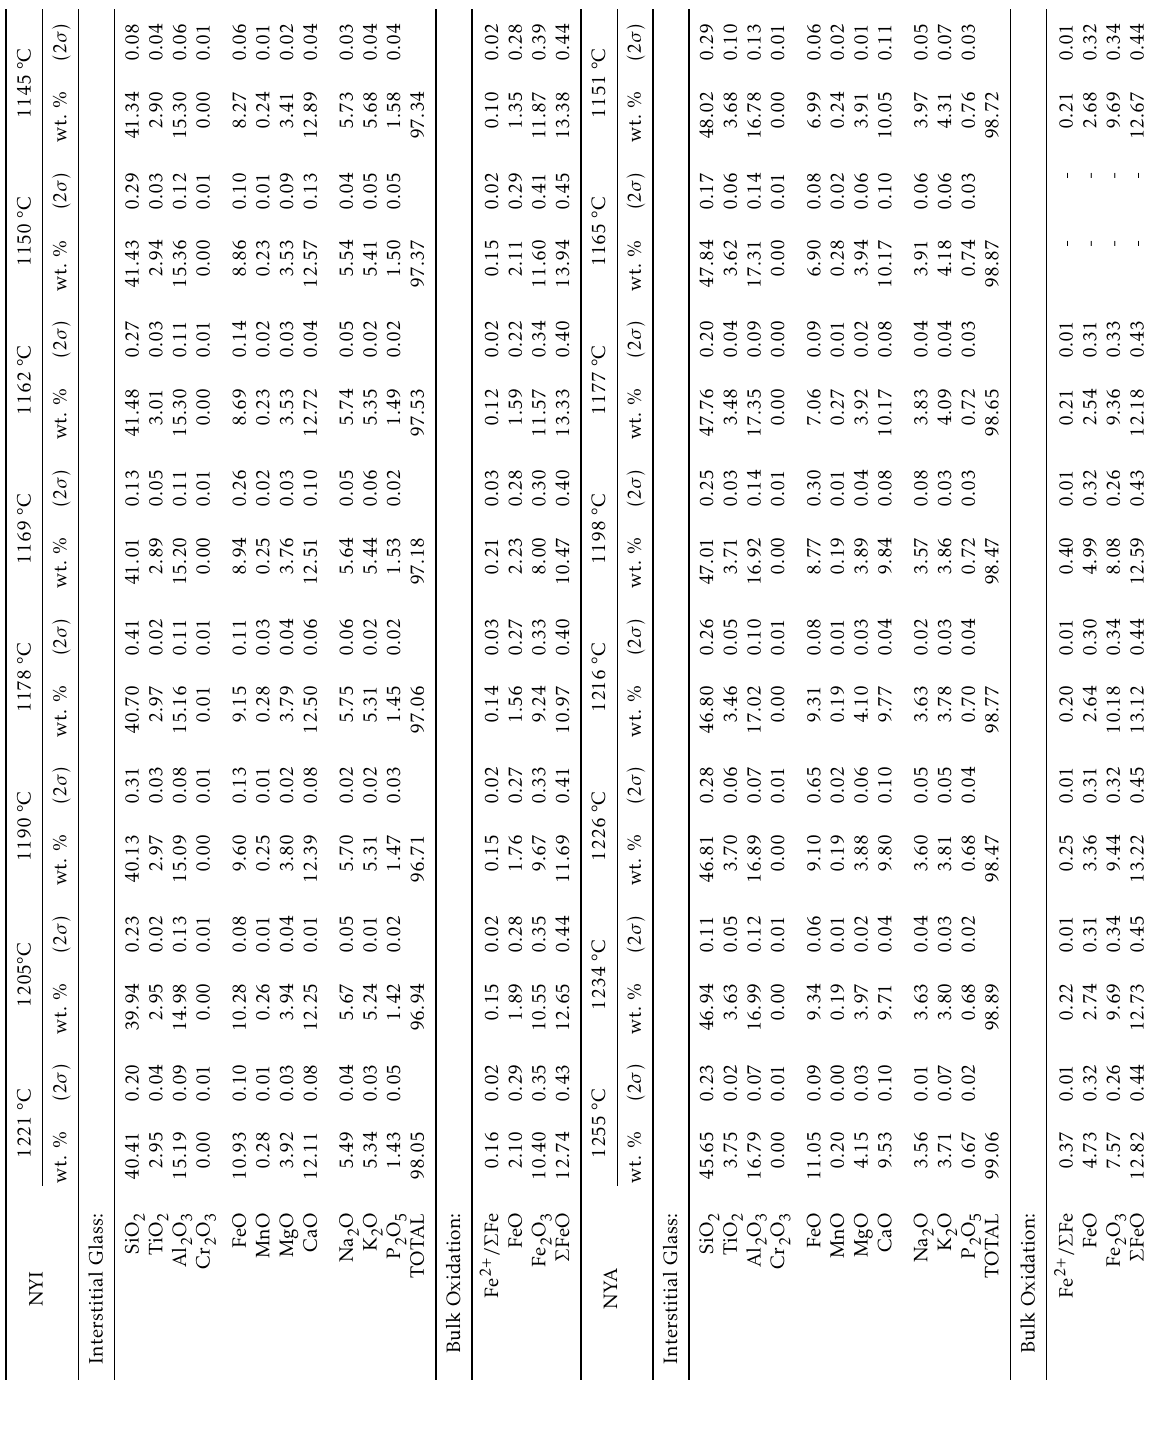
Table 4 – Interstitial liquid compositions (in wt.%) of each subliquidus experiment for NYI-2002 and NYA-1948. Oxidation state information is also reported for the bulk (crystals + glass) material from each subliquidus exper-